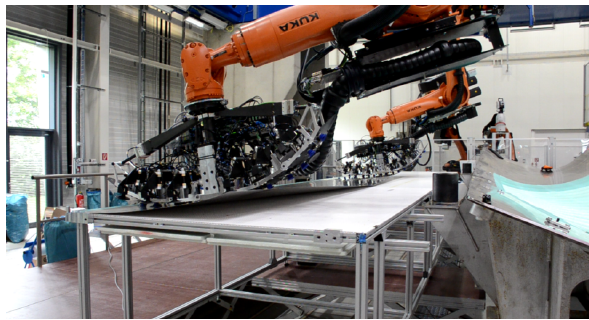
Figure 1: Pick-up of plane aluminum foils with cooperating robots © DLR